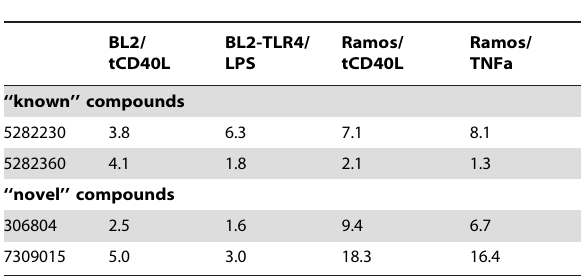
Table 2. Percent maximum inhibition for two ‘‘known’’ and two ‘‘novel’’ compounds in both BL2-NF k B-Luc and Ramos- NF k B-Luc cell